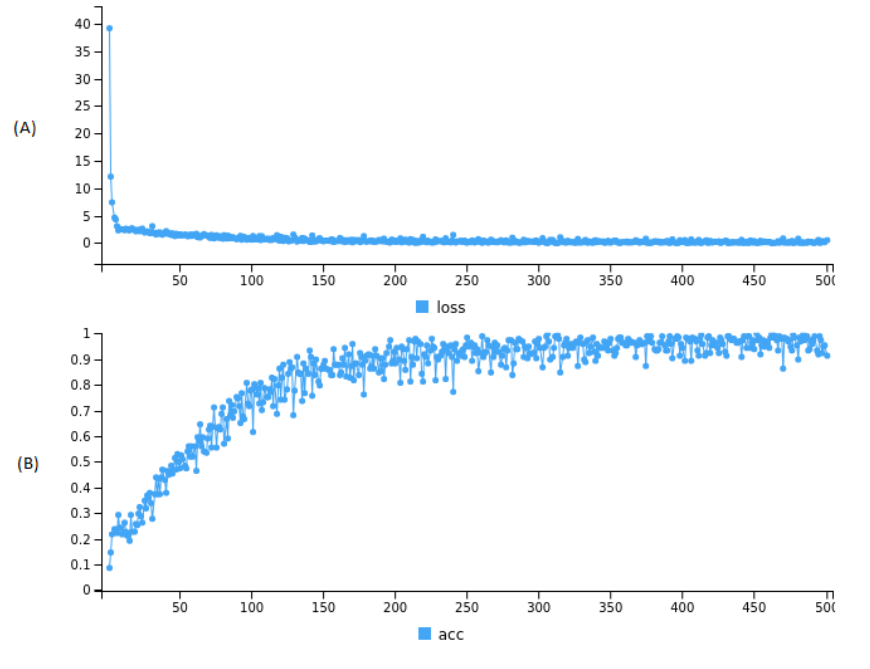
Figure 6. CNN training behavior based on ( A ) loss function and ( B )